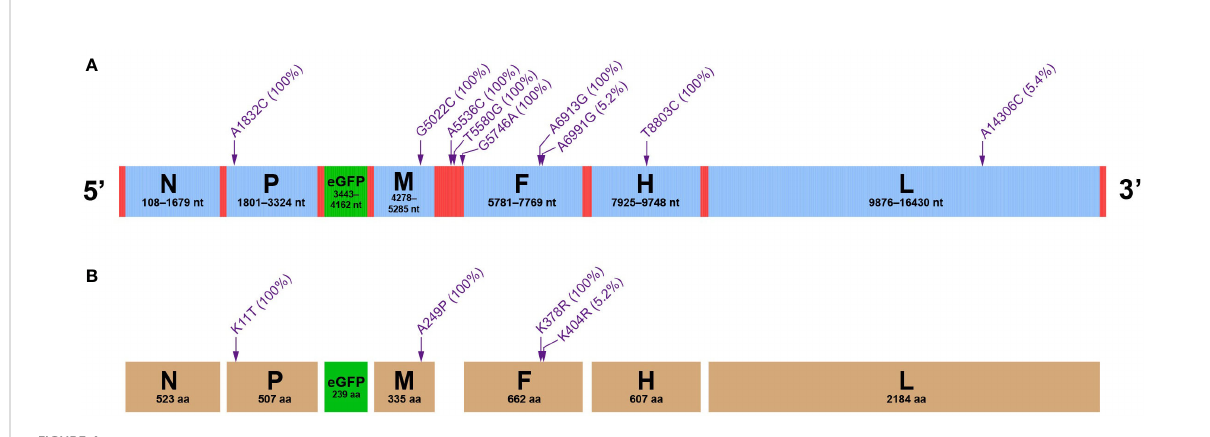
FIGURE 4 Mutation pro fi les of rCDV-eGFP at P47. Distribution of NGS-unveiled SNMs at rCDV-eGFP antigenome (A) . Distribution of SAAMs at structural proteins of rCDV-eGFP (B) . Arrow-indicated mutation sites do not exactly match their de fi nite positions at antigenomes and at proteins. Mutation frequencies are enclosed within